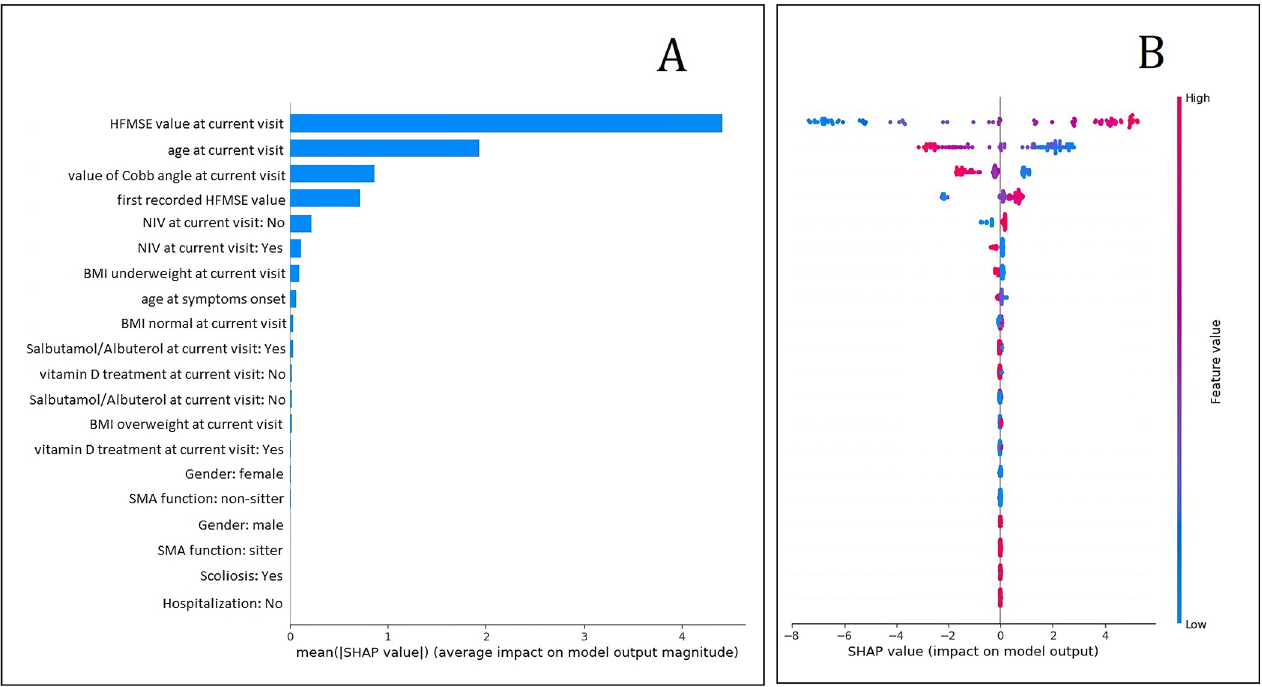
Fig 4. Top 20 features importance for 6 months model according to mean SHAP value (A) and SHAP value (B).